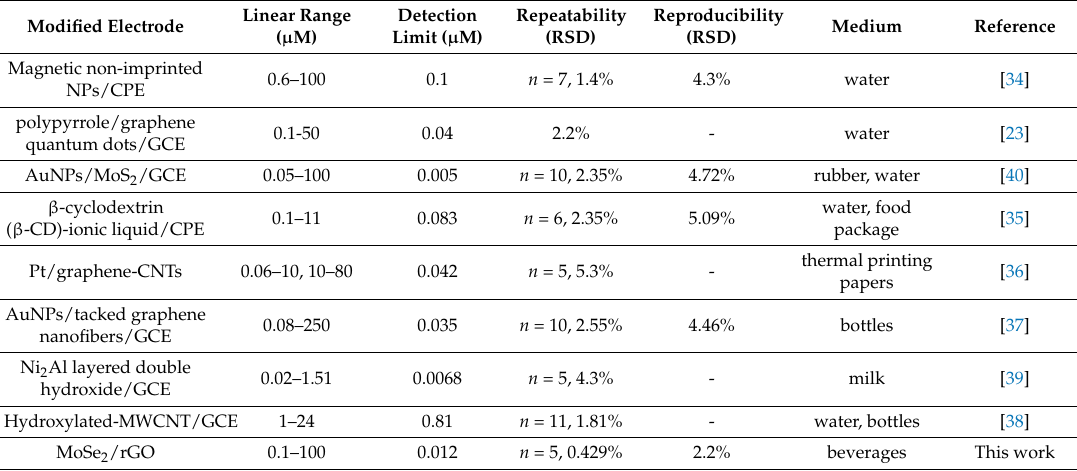
Table 1. Comparison of the MoSe 2 /rGO modified electrode for BPA determination with other modified electrodes (C BPA = 100 µ M).